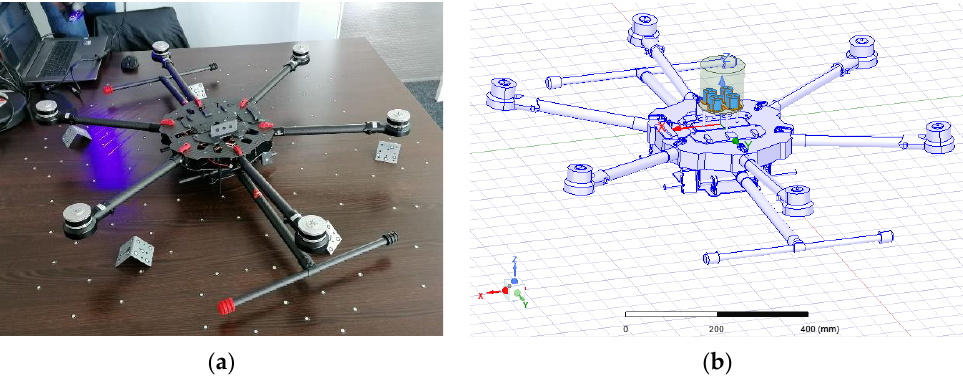
Figure 6. 3D scan of hex rotor UAV. ( a ) Scanning process. ( b ) 3D digital model of the scanned hex rotor UAV, imported into Ansys High Frequency Structure Simulator, with finite element model of the antenna array.